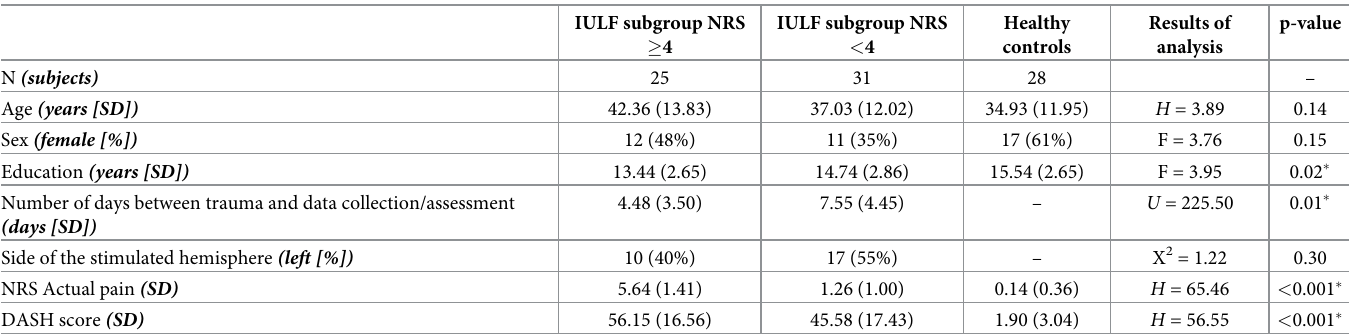
Table 1. Descriptive characteristics of study cohort by group.